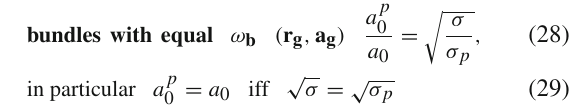
Fig. 7 Metric bundles Γ σ for the same plane σ and different bun- dle frequencies ω b ∈ { 0 . 01 (yellow), 1/27 (Red), 0.1 (dotted-dashed), 0.5 (cyan), 0.7 (orange), 1 (blue), 1.1 (pink), 1.5 (purple), 2 (green), 4